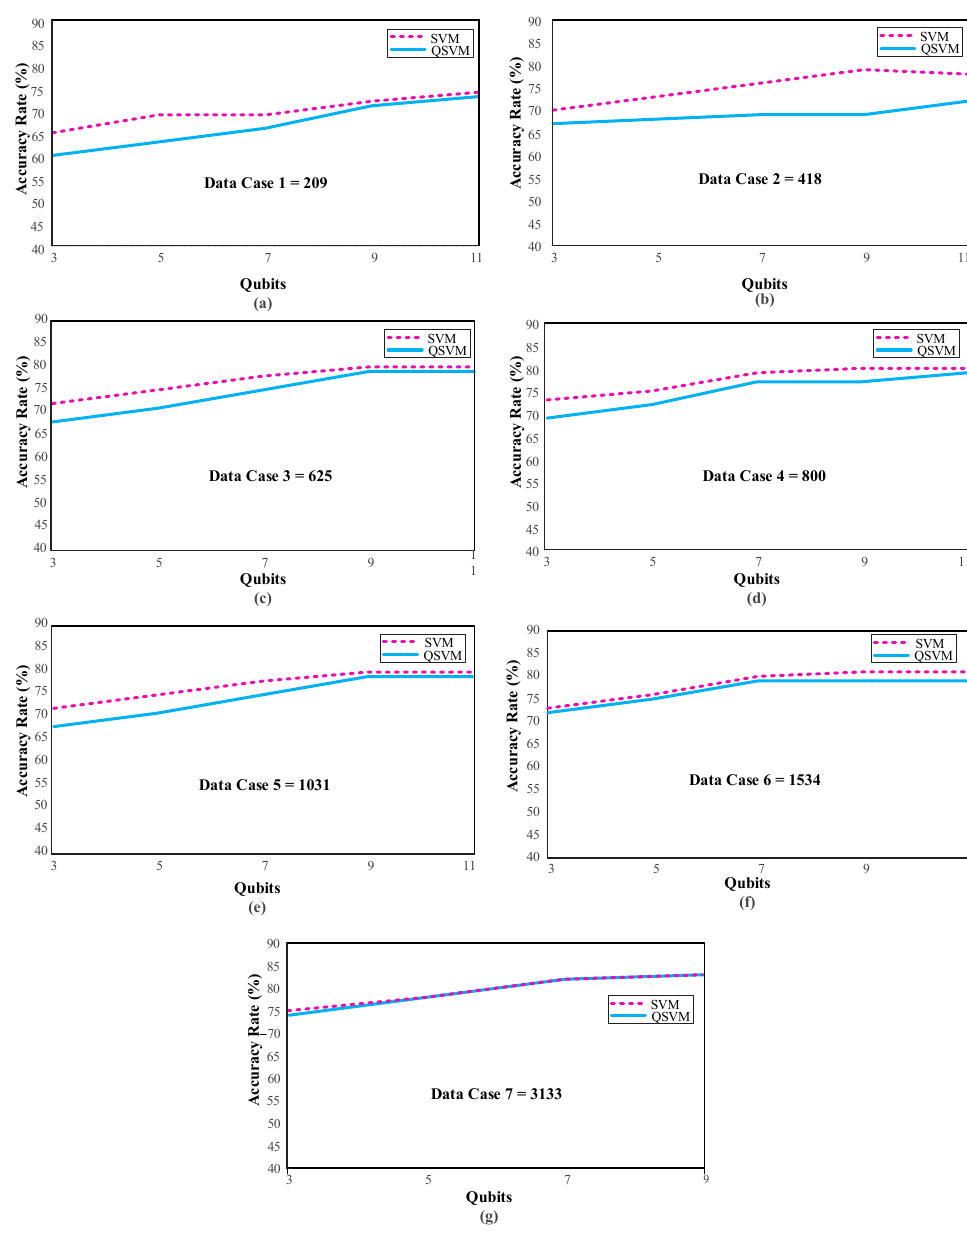
Figure 7. QSVM and SVM performances with di ff erent qubit numbers according to Data Case 1 ( a ), Data Case 2 ( b ), Data Case 3 ( c ), Data Case 4 ( d ), Data Case 6 ( e ), Data Case 6 ( f ), and Data Case 7 ( g ).